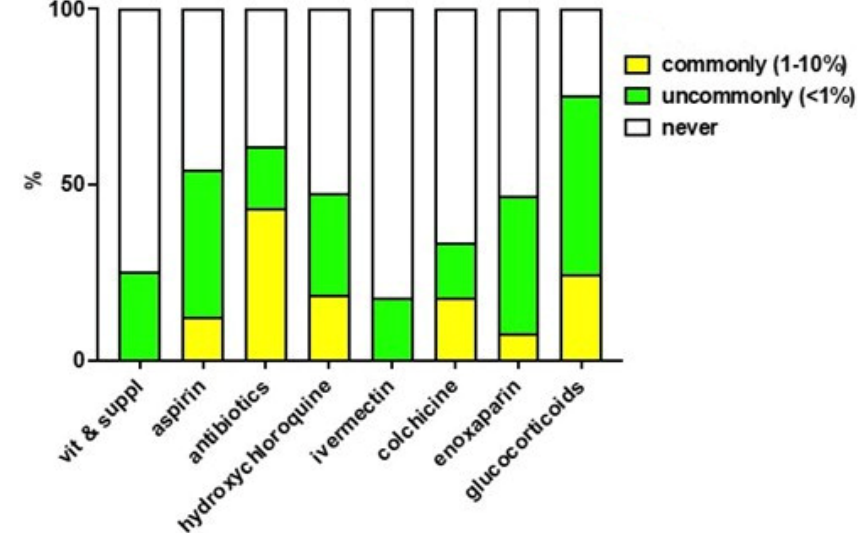
Figure 2. Perceived frequency of suspect ADR. Data is expressed as % of responding doctors weighted for the number of COVID-19 patients included in the present study for whom each doctor cared for.